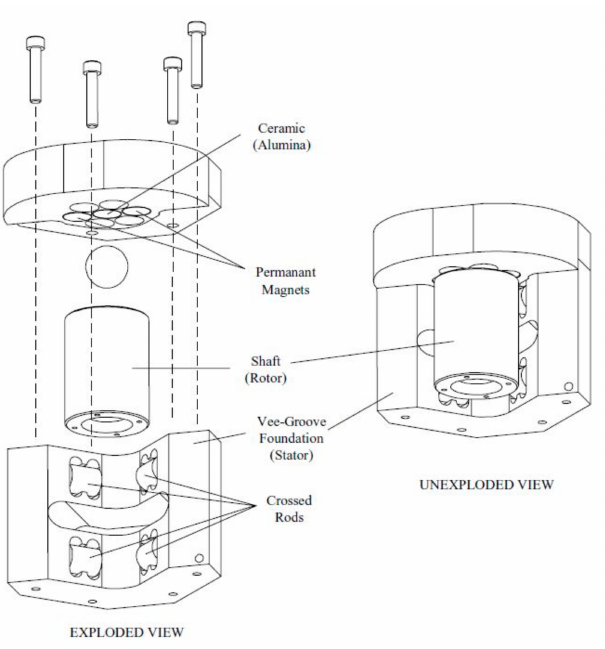
Figure 55. Kinematic alignment of the spindle cylinder at five points [20].